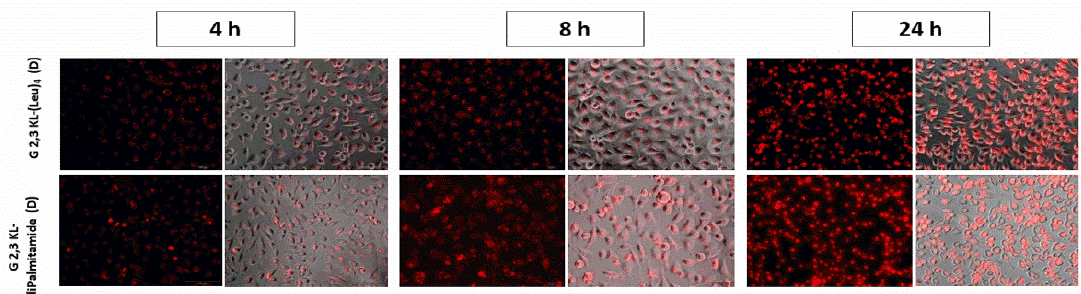
Figure 4. Cellular uptake as a measure of splice-correction levels of the lipophilic peptide dendrimers (G 2,3 KL-(Leu) 4 (D) and G 2,3 KL-diPalmitamide (D)) at different time points. Dendrimers were formulated in OptiMEM ® and HBG, respectively, and complexed with Alexa-568-labelled ON before HeLa Luc/705 transfection in serum-containing media. Live cells were rinsed with DMEM ® with no phenol red (Invitrogen), before imaging with the fluorescence microscope (Olympus IX81). (magnification 20×, Scale bar = 100 µm).